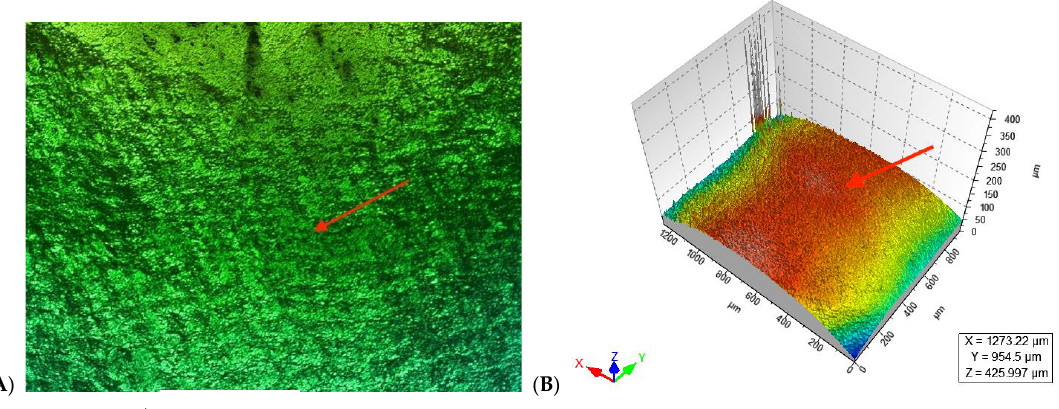
Figure 6. ( A ) Enamel appearance on confocal microscopy after debonding and polishing with a tungsten carbide bur low-speed handpiece (arrow points at only one area of enamel because it appears to have similar roughness on the entire surface); ( B ) 3D scheme of surface roughness of the selected representative sample for Group 3 (arrow points at the same area on the representative 3D model of the image´s roughness).